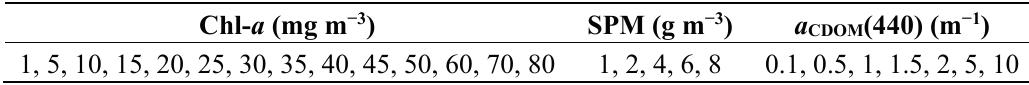
Table 1. Concentrations of chl- a and SPM, and absorption coefficient of CDOM at 440 nm, for which reflectance spectra were generated using Ecolight.